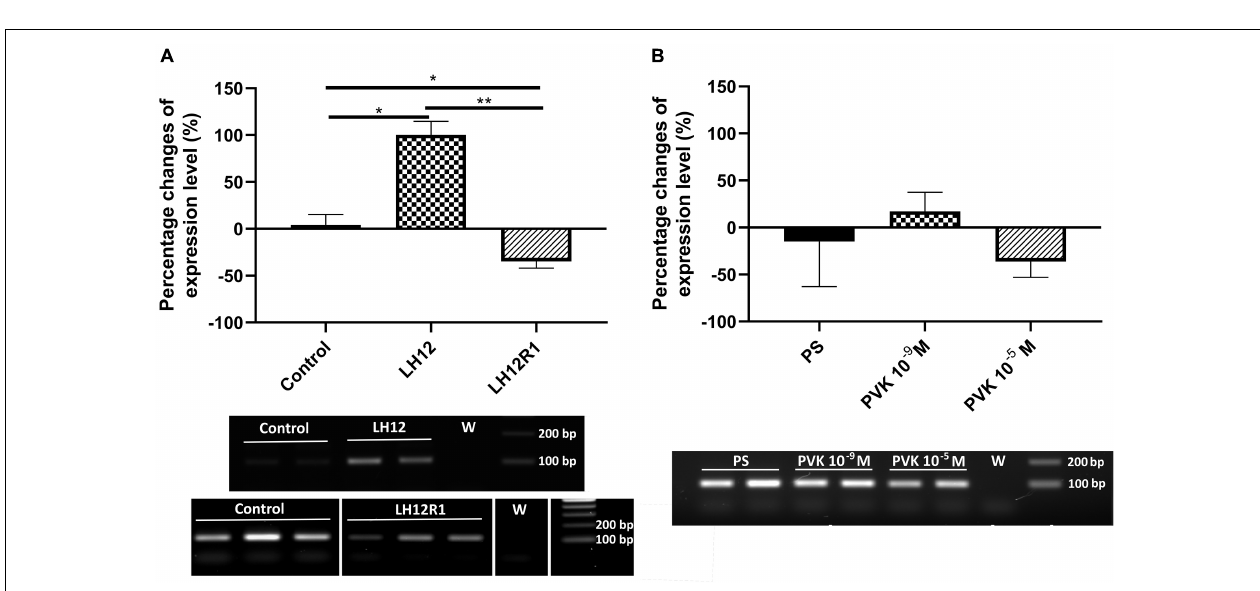
FIGURE 6 | Semiquantitative analysis of the expression level of gene encoding proPO, precursor for phenoloxidase in the N. vespilloides body. The samples were collected 12 h after exposition to low humidity (LH12R), 1-h recovery time (LH12R1) (A) , and 1 h after injection of one of the CAPA–PVK neuropeptide, Tenmo–PVK-2 at concentrations of 10 − 9 and 10 − 5 M (B) . Below are exemplary results of the semiquantitative RT-PCR analyses. The values are presented as mean ± SEM, * p ≤ 0.05, ** p ≤